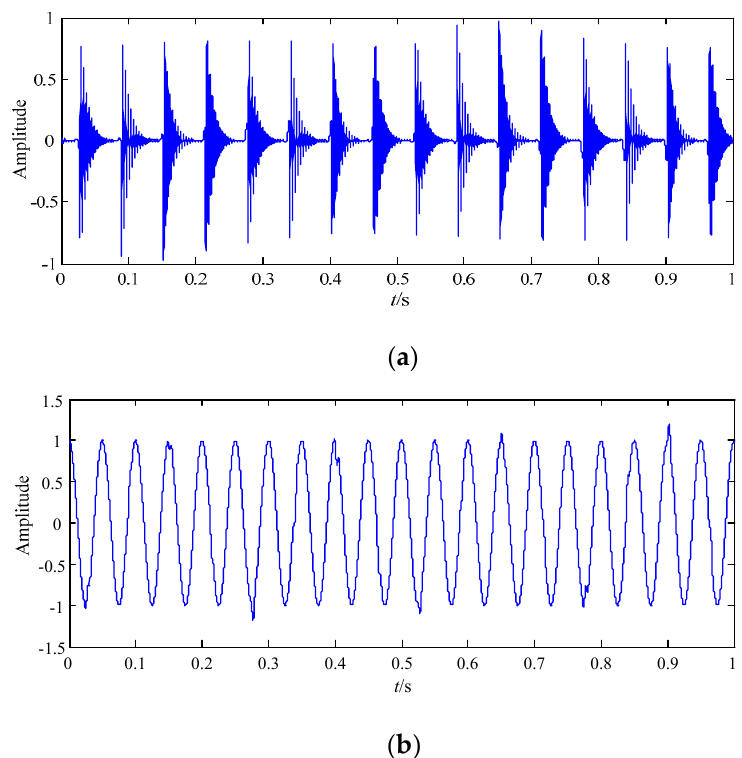
Figure 9. The best decomposition results of the simulated signal based on IEWT in the time domain.